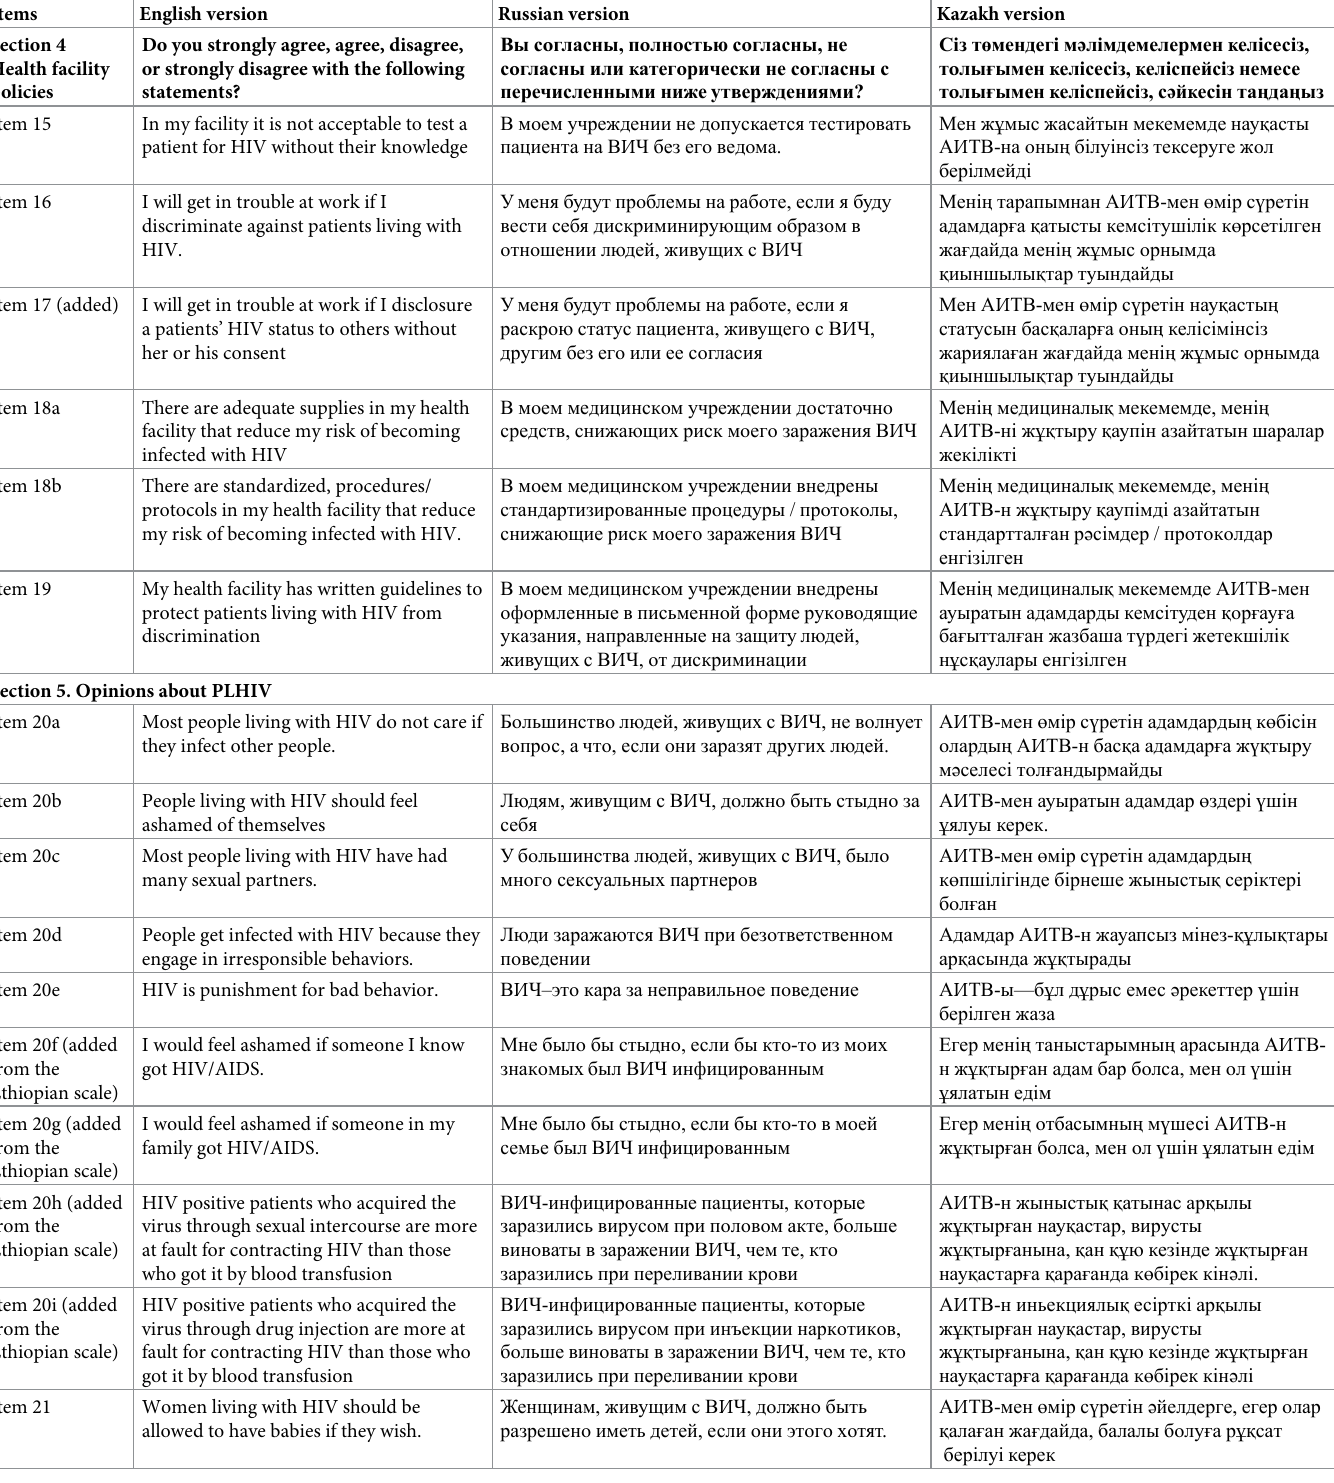
Table 1. HIV-related stigma measures in three study